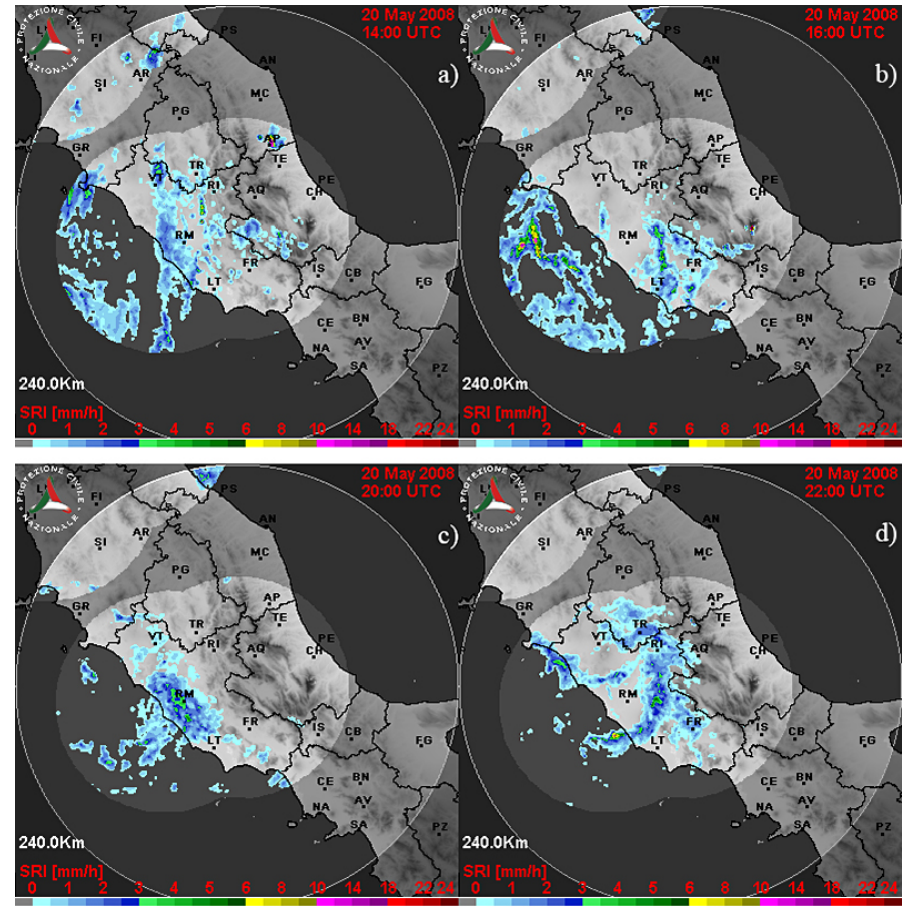
Figure 2. Estimated surface rainfall intensity (mmh) by the national radar network in central Italy on 20 May 2008: (a) SRI at 14:00UTC; (b) SRI at 16:00UTC; (c) SRI at 20:00UTC; (d) SRI at 22:00UTC. Only the highlighted areas were covered by the national radar network in 2008 (courtesy of the Italian Civil Protection Department).